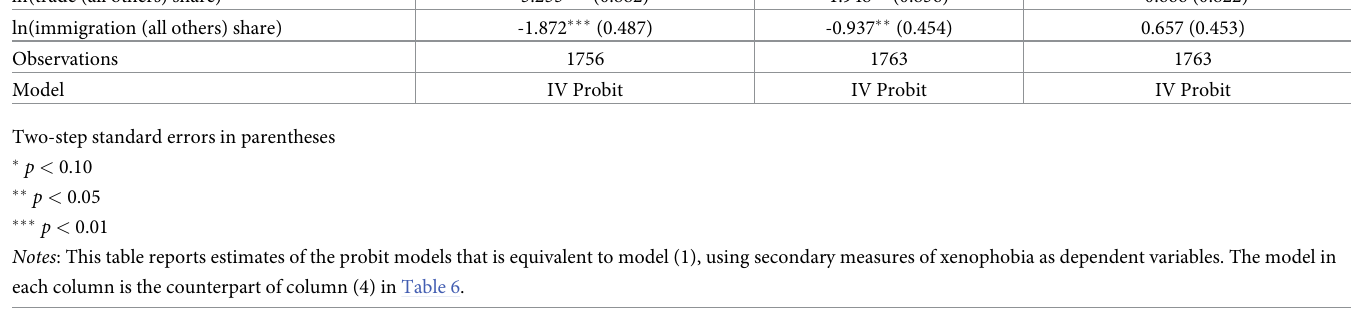
information available in the WVS dataset. Tables 8 and 9 report the results. For our preferred model, reported in column (4), the Kleibergen-Paap F-statistic for weak identification in the first stage is 296.2, greater than the Stock-Yogo weak ID test critical values at the most strin- gent 10% maximal IV size of 7.03. The first-stage estimates shows that instruments are strong, we omit them here for brevity and the results are available upon request. These estimates